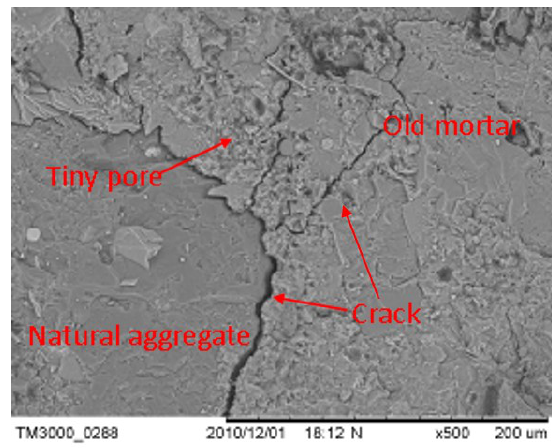
Figure 2: Micro-morphology of ITZ in recycled aggregate of Speci- men A3